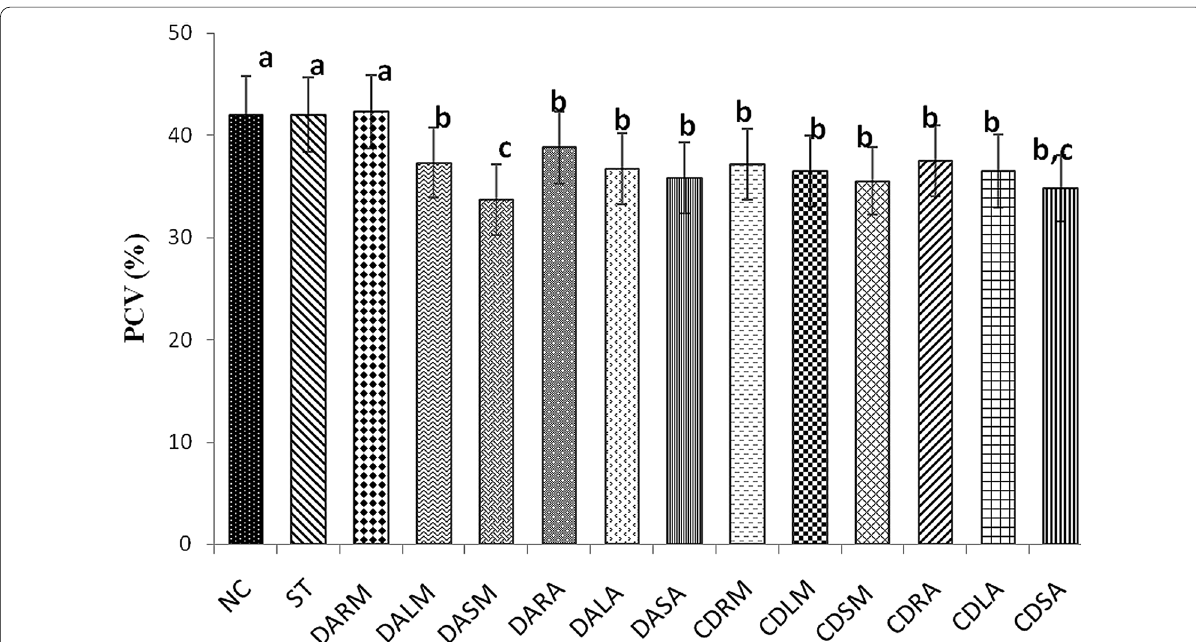
Fig. 1 Effects of methanolic and aqueous extracts of roots, leaves and stem of D. arborescens and C. dependens on Packed cell volume (PCV) of albino rats. Bars with similar alphabets are not statistically different ( p < 0.05). NC normal control, ST standard control, DARM D. arborescens root methanol, DALM D. arborescens leaves methanol, DASM D. arborescens stem methanol, DARA D. arborescens root aqueous, DALA D. arborescens leaves